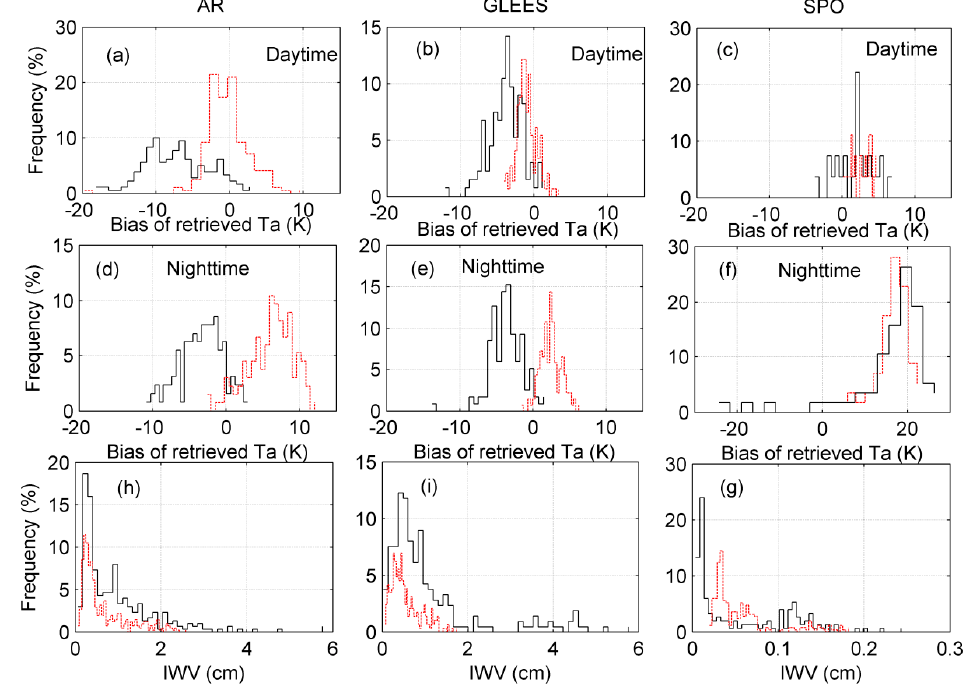
Figure 13. Comparison of MODIS-derived atmospheric parameters with those from NCEP at the sites AR (left column), GLEES (middle column), and SPO (right column). The solid line and dashed line represent parameters from MODIS and NCEP, respectively.